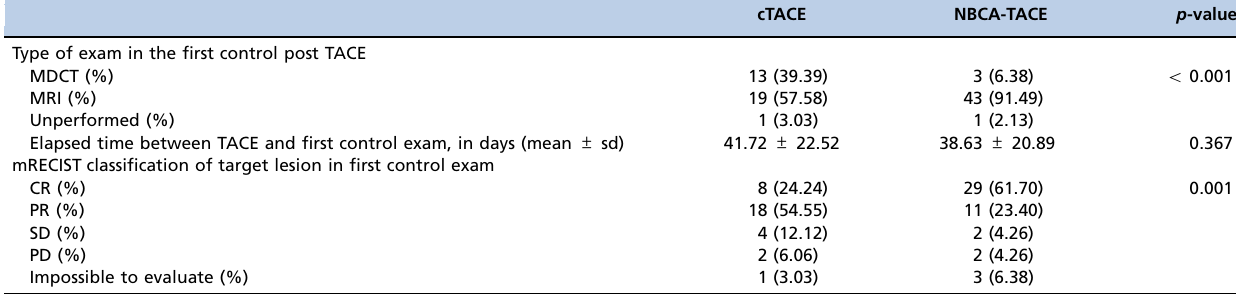
Table 2 - Findings in the first imaging control post